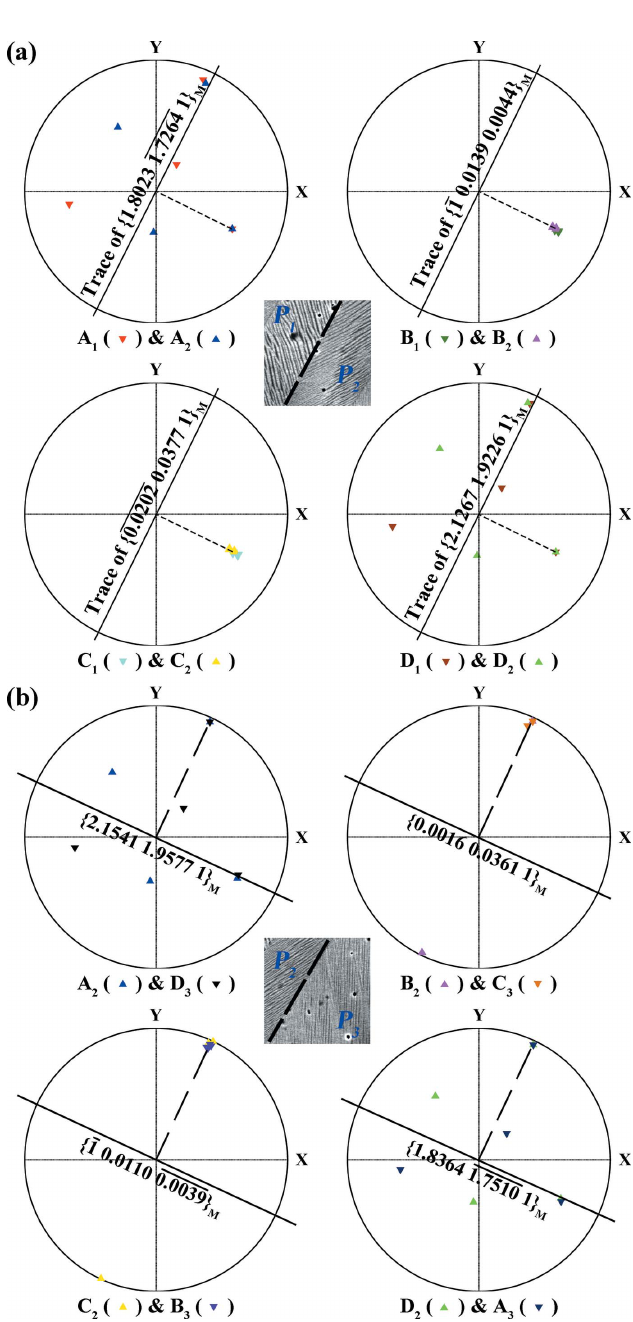
Figure 3 Stereographic projections of the common plane normal to the 180 (cid:2) rotation axis of each interplate variant pair at ( a ) P 1 / P 2 and ( b ) P 2 / P 3 that possesses a 180 (cid:2) rotation. The trace of the common plane is indicated by a solid black line and the rotation axis by a dashed black line. For comparison, the microstructures with the corresponding plate interface traces are displayed as